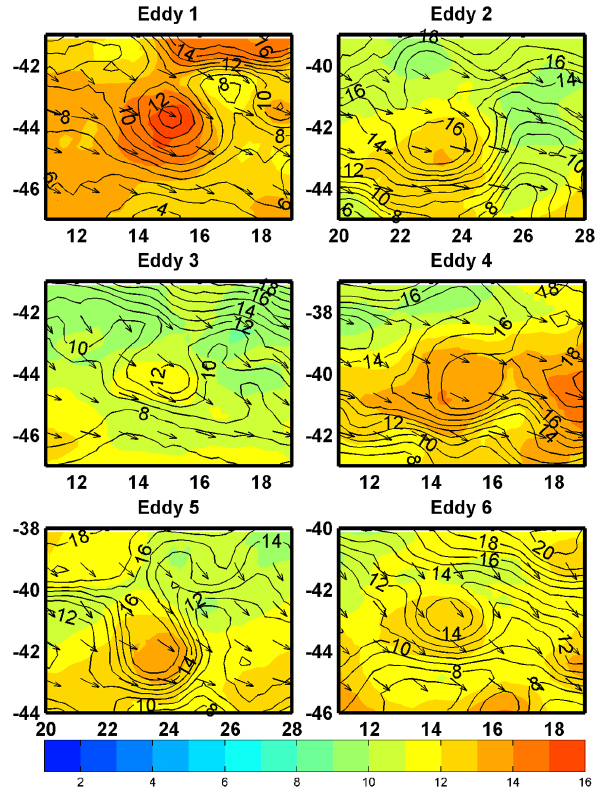
Figure 4. Mean weekly wind speeds in ms − 1 (colour) and direc- tions (arrows) and SST in ◦ C (contours) above the six eddies. Times given correspond to weekly means centred at 10 July 2002 for Eddy 1, at 4 September 2002 for Eddy 2, at 19 March 2003 for Eddy 3, at 16 July 2003 for Eddy 4, at 3 September 2003 for Eddy 5 and at 5 May 2004 for Eddy 6.